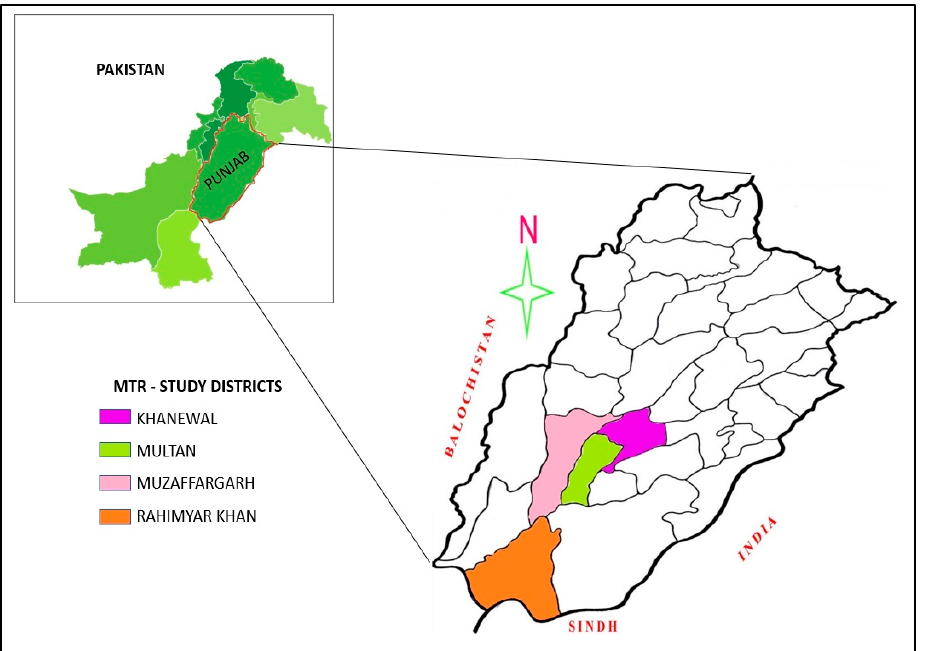
Figure 4. Map of Punjab province showing study districts.